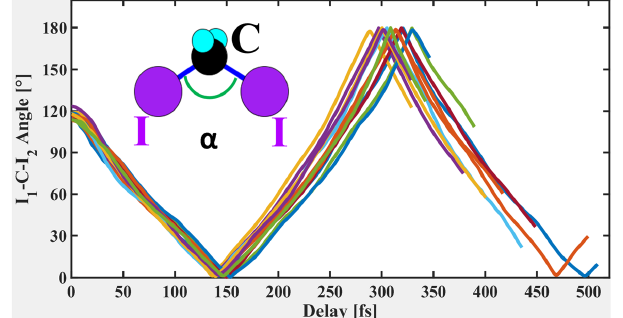
FIG. 17. I-C-I angle as a function of time for direct dissociation trajectories illustrating the rotation of the CH 2 group as the C-I bond is broken. A cartoon of the CH 2 I 2 molecule is shown inside the